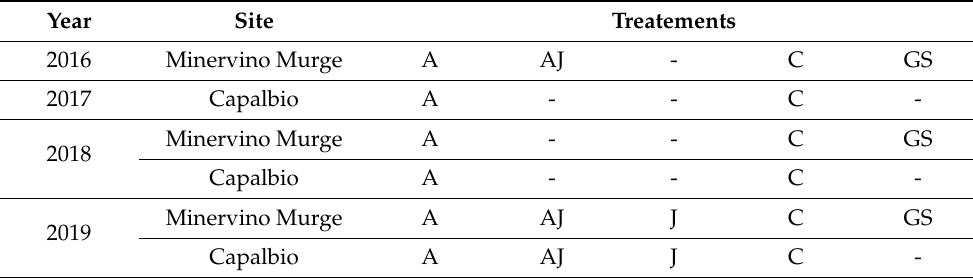
Table 2. Treatments tested in the different years in Minervino Murge and Capalbio vineyards. A: Isonet CGX111 dispensers applied only in April; AJ: Isonet CGX111 dispensers applied twice,